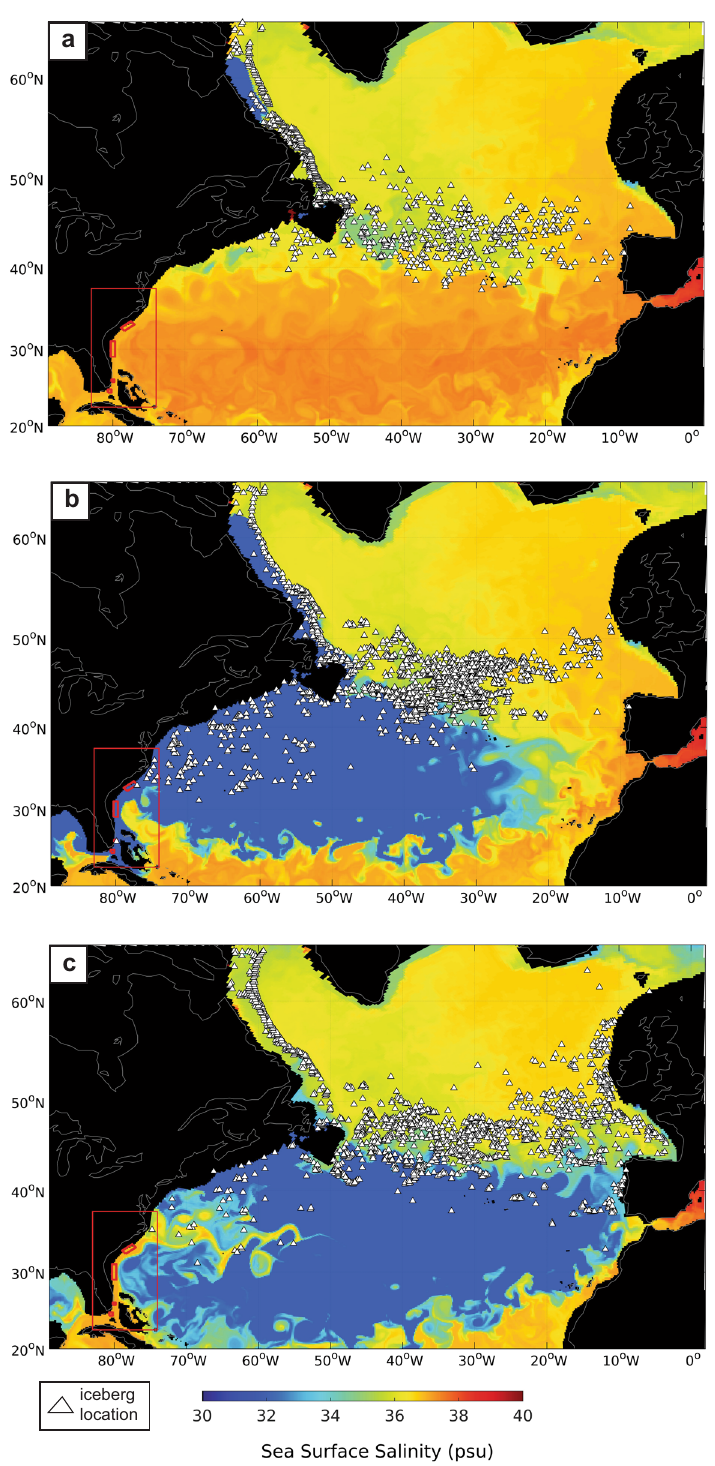
Fig. 10 Simulated sea surface salinity and the distributions of icebergs in the glacial North Atlantic. The top panel ( a ) shows that at the onset of the meltwater event, icebergs (denoted by the white fi lled triangles) are primarily restricted to the region 40°N – 50°N, where high concentrations of ice-rafted debris (IRD) are found in marine sediments. After 1 year of elevated meltwater discharge (panel b ), the geographical distribution of icebergs has expanded to include the subtropical North Atlantic. Once the meltwater discharge is reduced (panel c — drawn 1 year after the meltwater fl ood ended), icebergs become restricted to the subpolar North Atlantic even though the freshwater signature of the meltwater persists in the subtropical